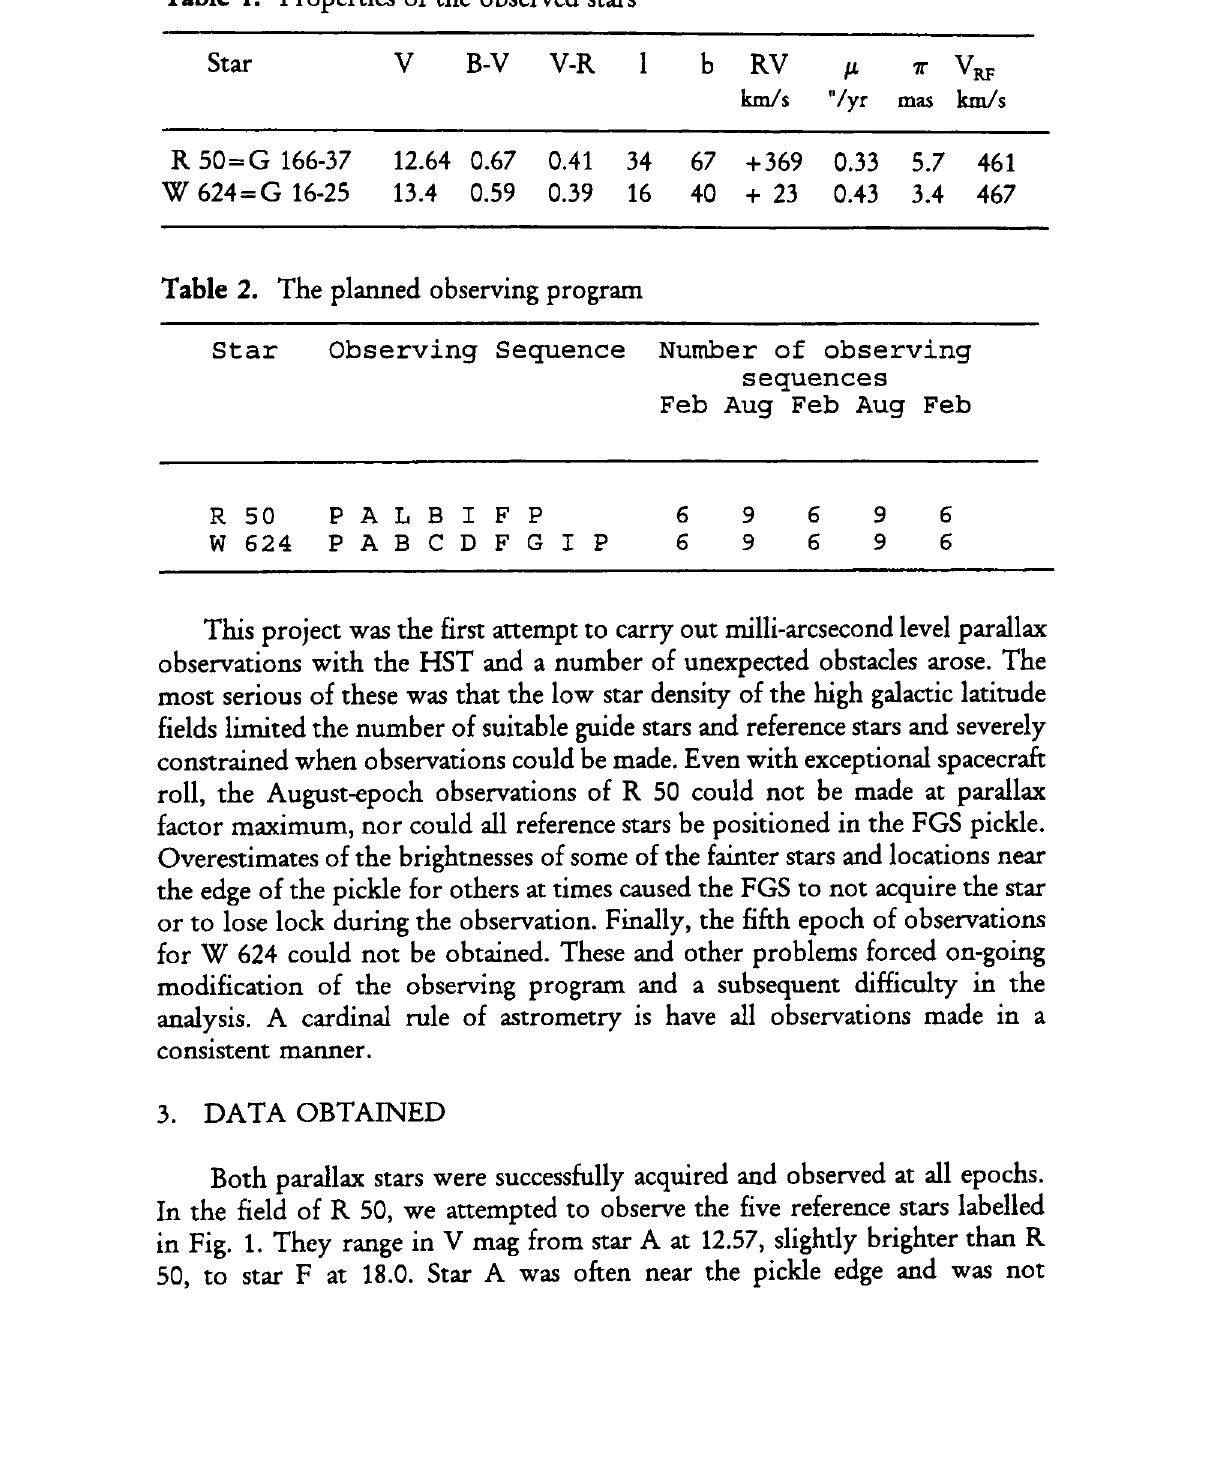
Table 1. Properties of the observed stars Star V B-V V-R 1 RV